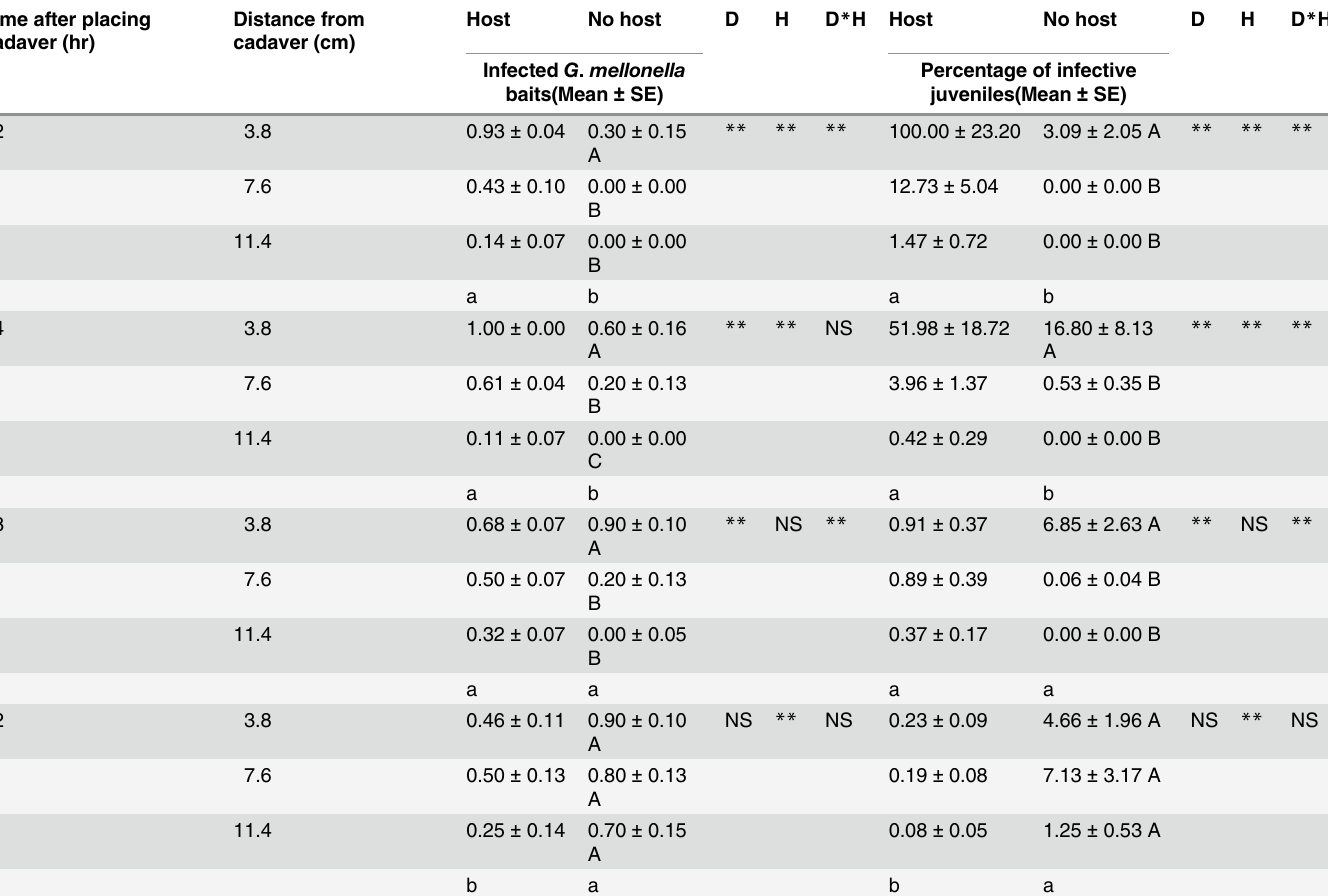
Mean ( ± SE) number of infected Galleria mellonella baits from the collected soil core samples and mean ( ± SE) percentage of infective juveniles (IJs) of Steinernema carpocapsae dispersed to a 2 cm wide annulus at distances, 3.8, 7.6 and 11.4 cm over a period of 12 to 72 hr in the presence of 2 mobile hosts, G . mellonella larvae placed outside the wire mesh cylinder (3.8 cm dia) enclosing the source cadaver in the microcosms containing autoclaved fi eld soil with vegetation as opposed to similar microcosms containing no hosts. Double asterisk ( ** ) indicates signi fi cant difference between distances (D), presence or absence of the host (H) and interaction between the two (D * H) at a time point at P (cid:1) 0.05. Capital and small letters indicate Tukey ’ s comparison for means separation between distances averaged over presence or absence of the host, and presence and absence of host averaged over distances, respectively at a time point. NS = P >